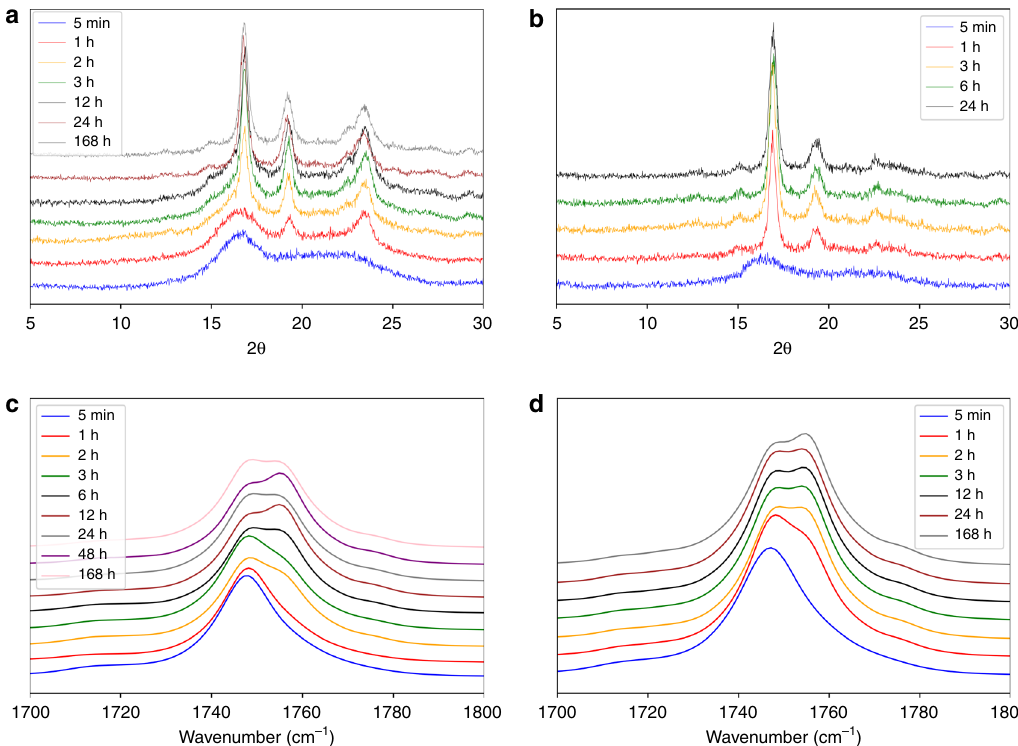
Fig. 2 Kinetics of PLLA crystallization. a , b WAXS pattern for PLLA 45 - b -PEG 45 (10% solids w/w 9) ( a ) and PLLA 90 - b -PEG 45 (10% solids w/w 15) ( b ) over time and c , d FTIR spectra of the carbonyl shift for 9 ( c ) and 15 ( d ). Note for ( a ), from 24 h to 168 h, no signi fi cant difference is observed. For ( b ), from 3 h to 24 h, no signi fi cant difference is observed. Note that for ( a ), 5 min and 1 h, and 2b, 5 min show metastable crystalline intermediates. The data show a development in the crystallinity over time indicating that the self-assembly process measured in Fig. 1 is related to the crystallization of the PLLA core- forming